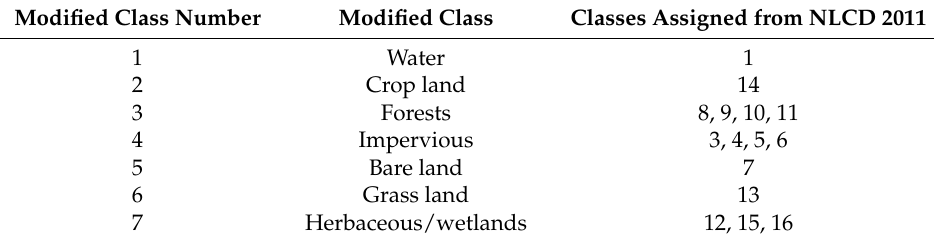
Table 2. Developed land cover classes.